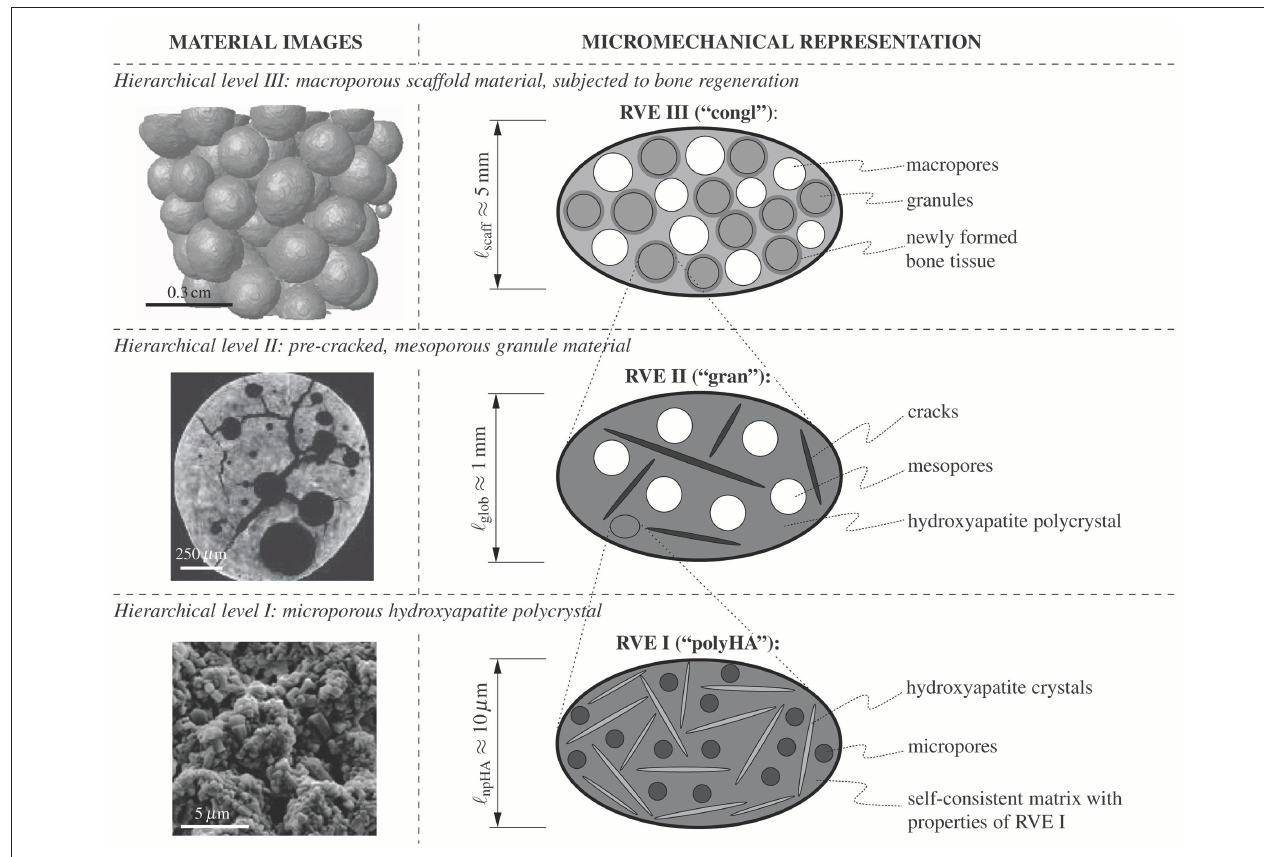
FIGURE 1 | Investigated material system. Three-level representation of the hydroxyapatite-based granular biomaterial (column on the right-hand side), following the morphological features found in images on different observation scales (column on the left-hand side); the depicted images have been acquired by means of scanning electron microscopy (hierarchical level I) and µ CT imaging techniques (hierarchical levels II and